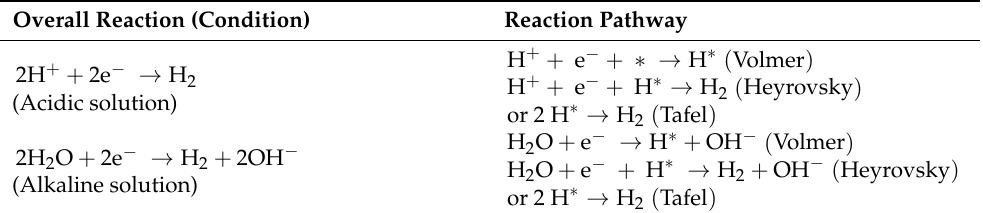
Table 5. Overall reaction pathways for HER in acidic/alkaline